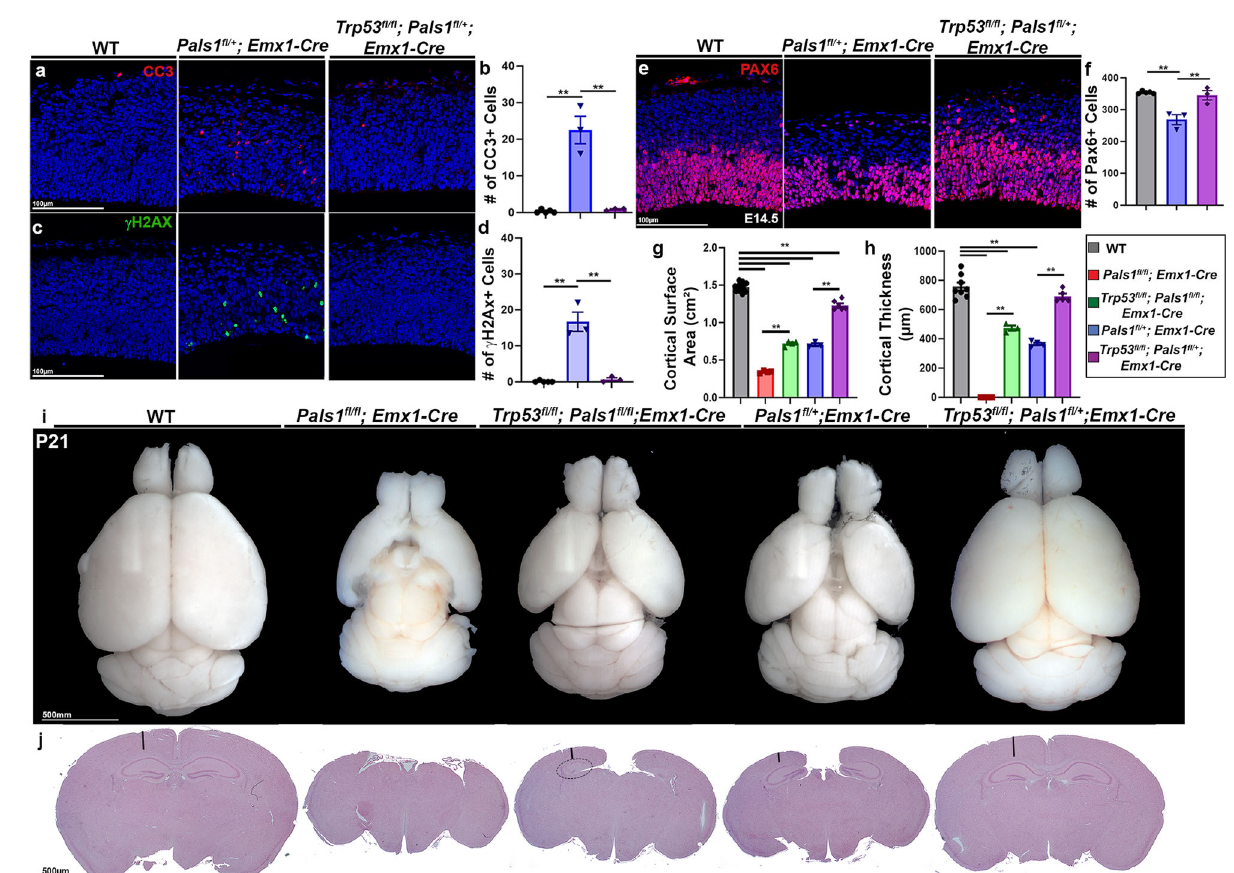
Fig. 4 | Trp53 deletion signi fi cantly rescues PALS1 microcephaly pathology. a – d Immunostaining and quanti fi cation of markers of cell death (CC3) and DNA damage ( γ H2AX) (WT n =5 brains, Pals1 fl /+ ; Emx1-Cre n =3 brains, Trp53 fl / fl ; Pals1 fl /+ ; Emx1-Cre n =3 brains, cell death ( P =<0.0001, F =41.05, dof=13), DNA damage ( P =<0.0001, F =42.56, dof = 13). e , f Immunostaining and quanti fi cation of PAX6 + apical progenitors at E14.5 (WT n =5 brains, Pals1 fl /+ ; Emx1-Cre n =3 brains, Trp53 fl / fl ; Pals1 fl /+ ; Emx1-Cre n =3 brains ( P =.0002, F =18.04, dof=13). g , h Quanti fi cation of cortical surface area and thickness (WT n =8 brains, Pals1 fl / fl ; Emx1-Cre n=6 brains, Trp53 fl / fl ; Pals1 fl / fl ; Emx1-Cre n =3 brains, Pals1 fl /+ ; Emx1-Cre n =4 brains, Trp53 fl / fl ; Pals1 fl /+ ; Emx1-Cre n =5 brains, surface area ( P =<0.0001, F =572.6, dof=25),